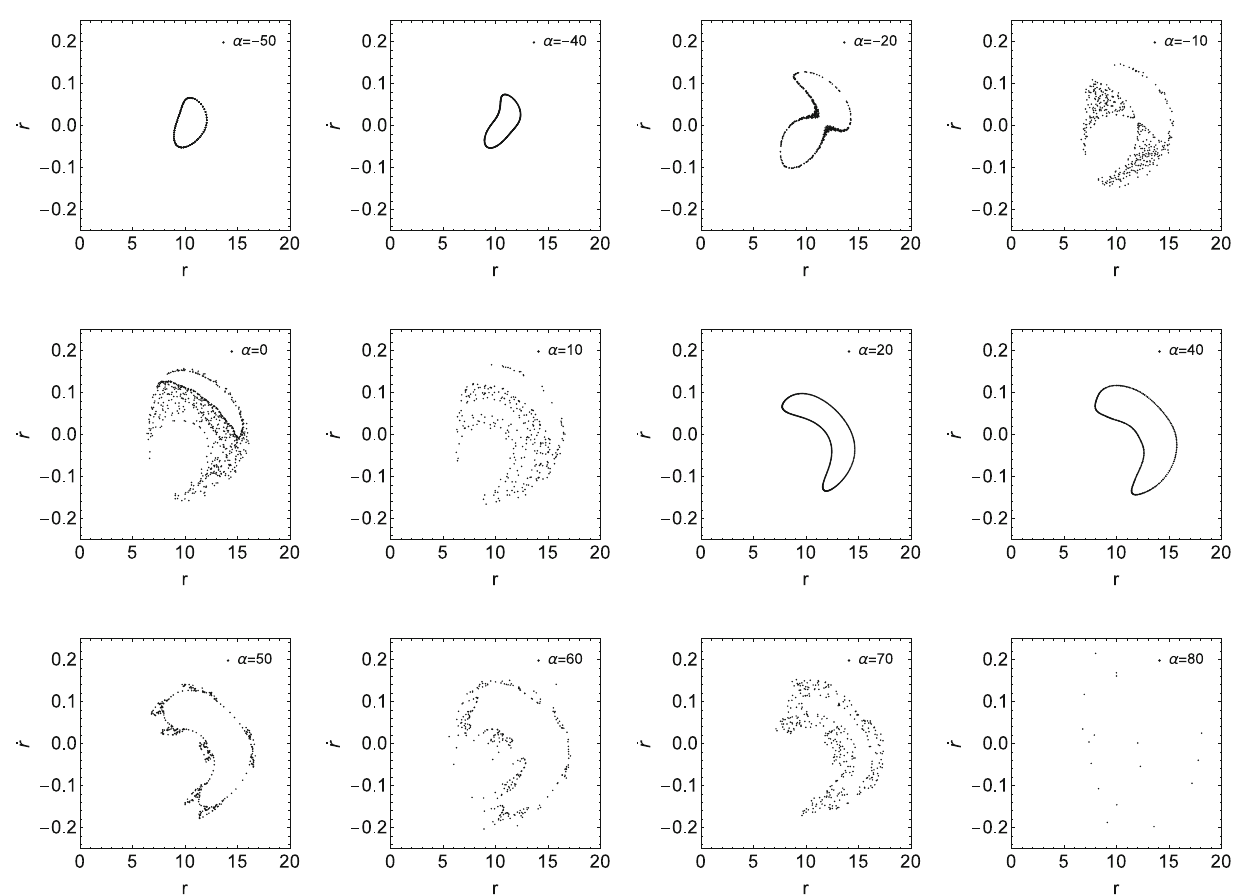
Fig. 5 The Poincaré surface of section ( θ = 2 π ) with different coupling parameter α and fixed B = 0 . 02. The initial conditions are set as 5 r ( 0 ) = 12 . 0, θ( 0 ) = 3 π and ˙ r ( 0 ) = 5